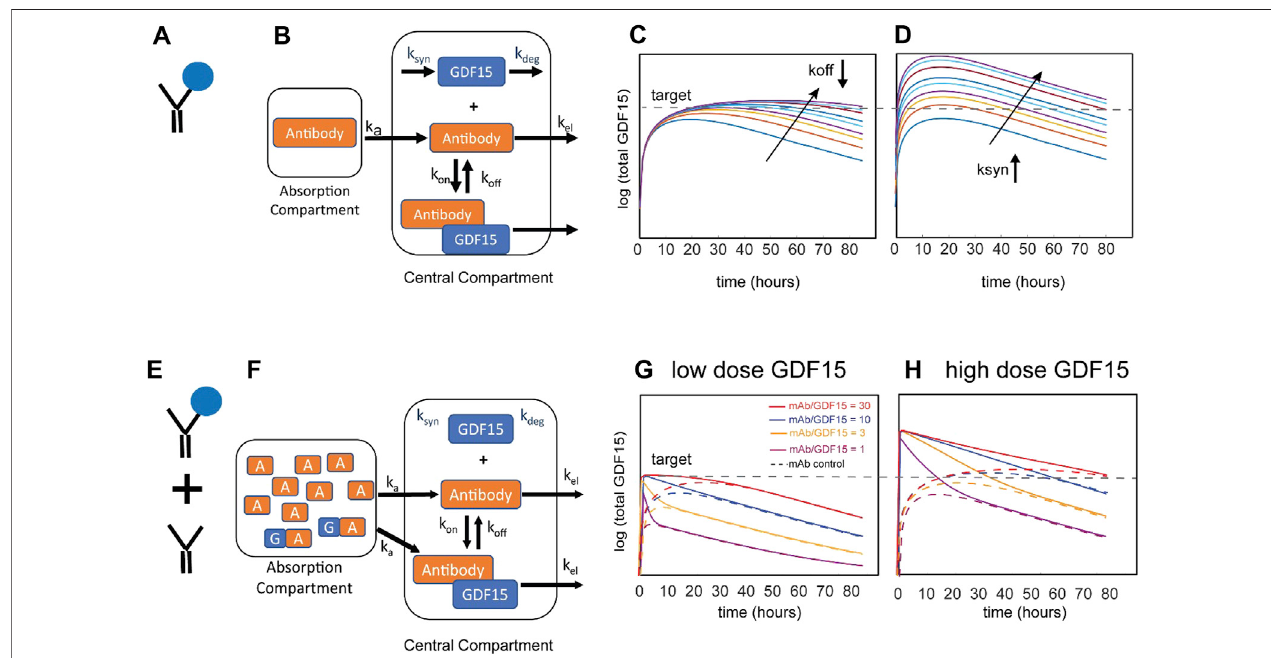
FIGURE 1 | Schematic of the model for the Novartis case study and resulting simulations. Stabilization of endogenous GDF15 ligand via binding to therapeutic antibody (A) can be described with a one-compartment model (B) . Results of local parameter scans for increasing the stability of the GDF15:antibody complex (C) and increasing the pool of endogenous GDF15 (D) . The arrows represent rate constant modi fi ers from 1 ȕ to 1/25 ȕ (decreasing k off ) or 1 ȕ to 25 ȕ (increasing ksyn), respectively. Administration of a mixture of stabilizing therapeutic antibody and recombinant GDF15 (E) can be described by the same one-compartment model (F) .Simulationsofdifferentmixturecompositionswithalow (G) orhigh (H) doseofexogenousGDF15.ShowninthesolidlinesarefourratiosofantibodytoGDF15(30:1, 10:1, 3:1, 1:1 or equimolar). The stippled lines represent an antibody-only control for each of the four